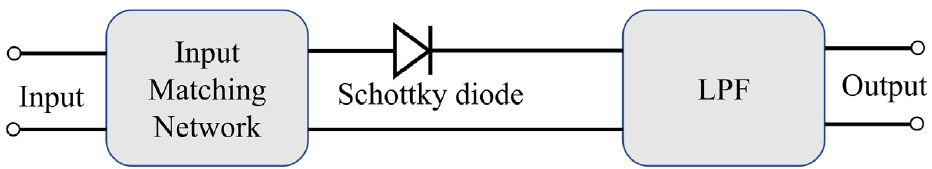
Figure 7. The block diagram of the detector circuit.